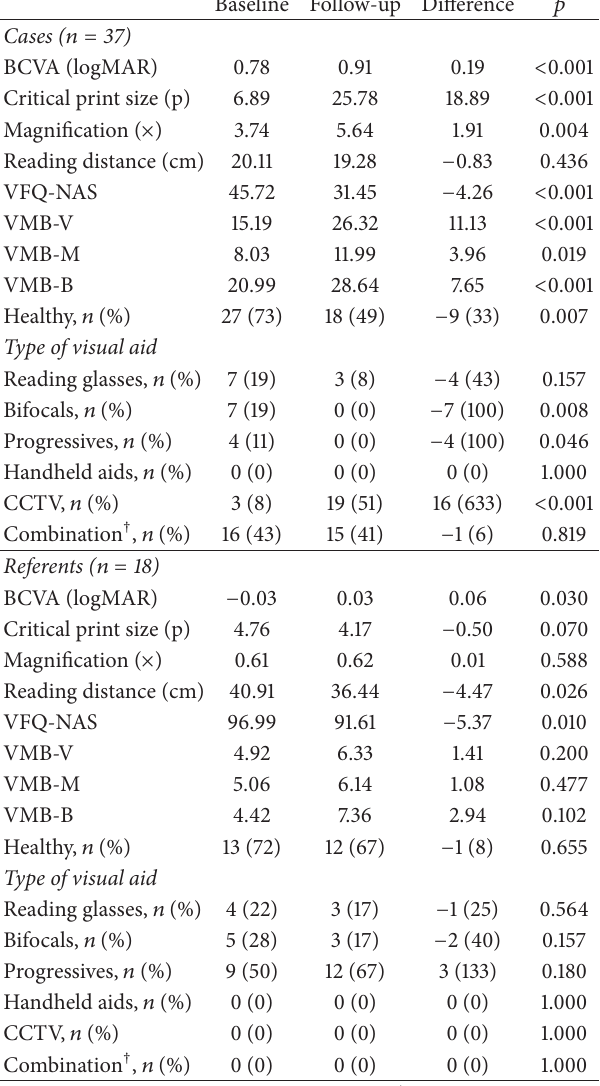
Table 2: Descriptive statistics of AMD patients and age-matched control group with normal vision at baseline and follow-up.